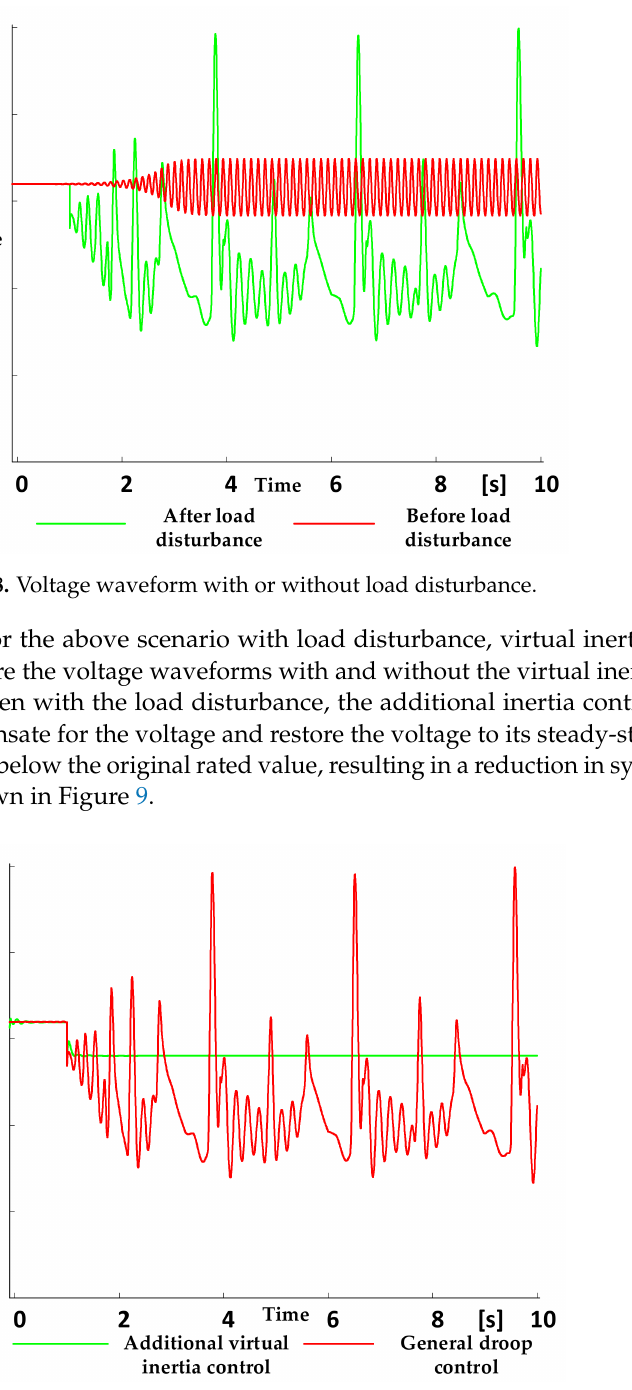
Figure 9. Voltage waveform with or without virtual inertia control under load